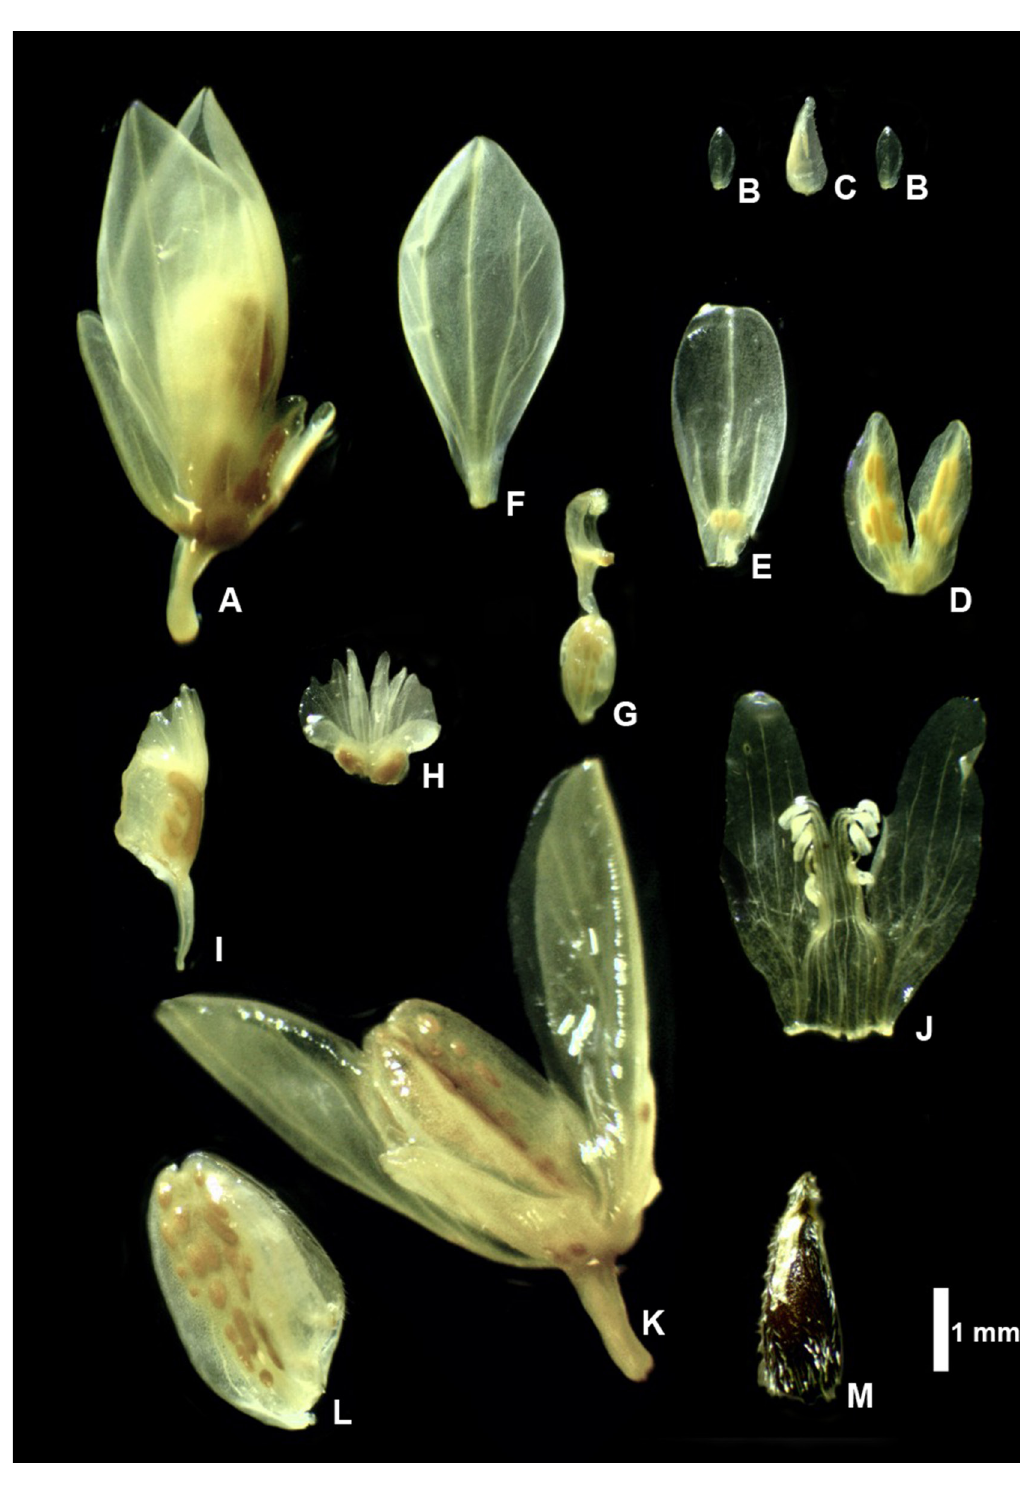
Fig. 1. Polygala bringelii J.F.B.Pastore & Antar sp. nov. A . Flower. B . Bracteoles. C . Bract. D . Two upper outer sepals. E . Lower outer sepal. F . One of the two inner sepals (wings). G . Gynoecium. H . Crest. I . Keel. J . Androecium and lateral petals. K . Fruit with persistent calyx. L . Capsule. M . Seed. All from G.M. Antar and L. Nascimento 380. Photos: J.F.B.